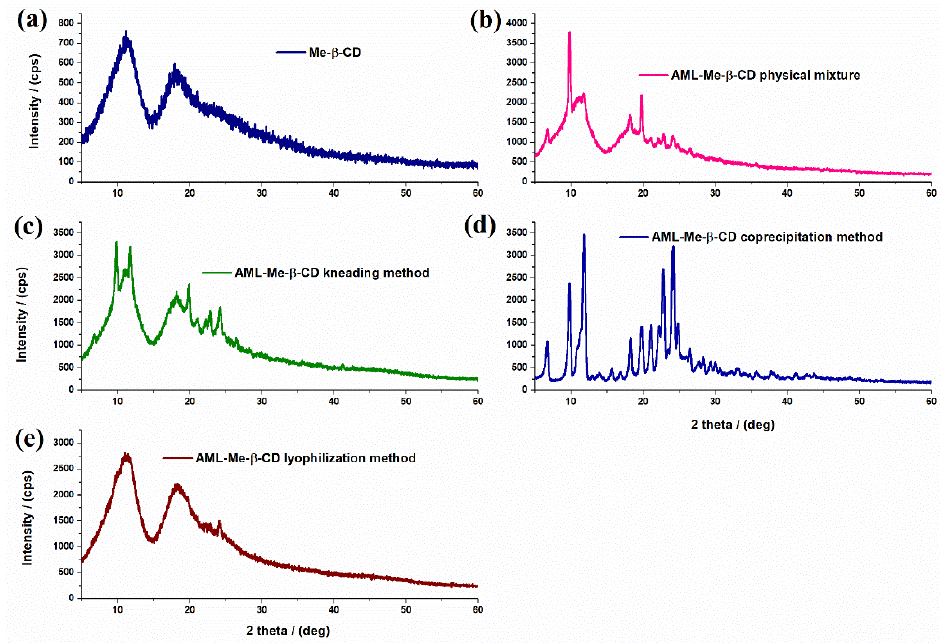
Figure 6. XRD patterns of ( a ) Me- β -CD, ( b ) AML-Me- β -CD physical mixture, ( c ) AML-HP- β -CD kneading method, ( d ) AML-HP- β -CD coprecipitation method, and ( e ) AML-HP- β -CD lyophiliza- tion method.